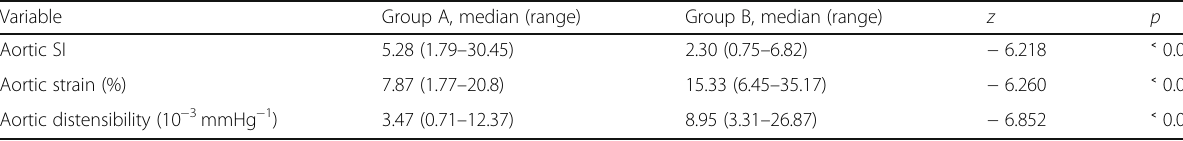
Table 1 Aortic stiffness parameters in SLE patients (group A) and controls (group B) Variable Group A, median